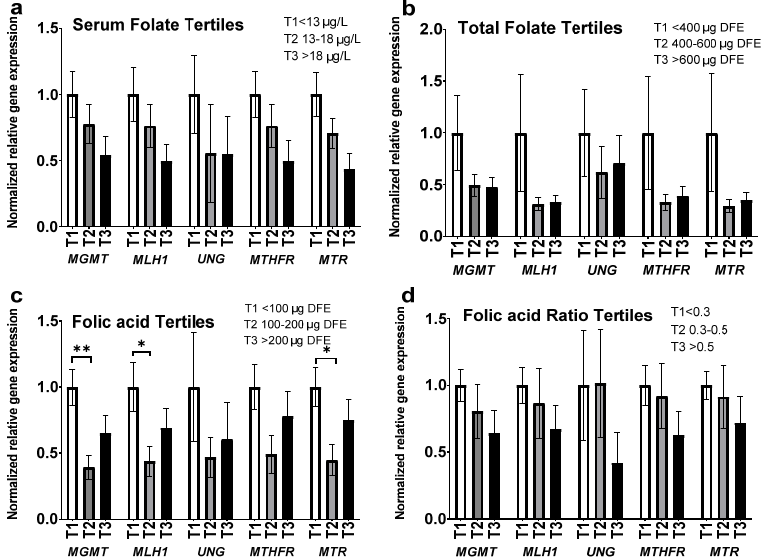
Figure 5. Normalized relative gene expression of O-6-methylguanine-DNA methyltransferase ( MGMT ), mutL homolog 1 ( MLH1 ), uracil DNA glycosylase ( UNG ), 5,10-methelenetetrahydrofolate- reducatase ( MTHFR ), and 5-methyltetrahydrofolate-homocysteine methyltransferase ( MTR ) relative to: ( a ) serum folate tertiles 1. ( b ) Total dietary folate intake tertiles. ( c ) Dietary folic acid intake tertiles. ( d ) Dietary folic acid intake: total folate intake ratio tertiles (FAR). Serum folate presented as µ g/L (ng/mL), DFE; (dietary folate equivalent), data presented as mean ( ± SEM), n = 33, * p < 0.05, ** p <